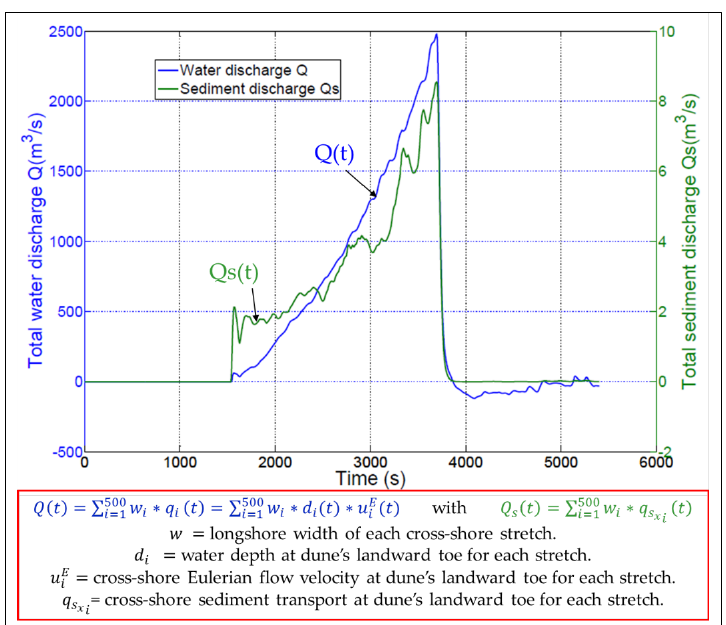
Figure 14. Total inland discharge of water ( Q ) and sediment ( Q s ) calculated at the landward toe of the dune under the rectangular load case (LC1).